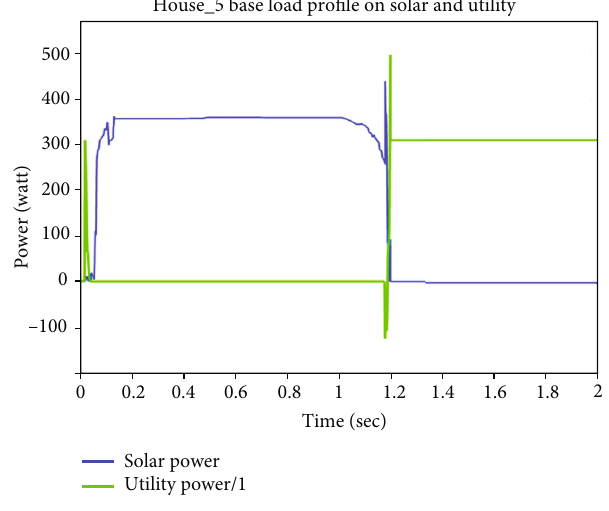
Figure 38: Basic load pro fi le of house no. 5.